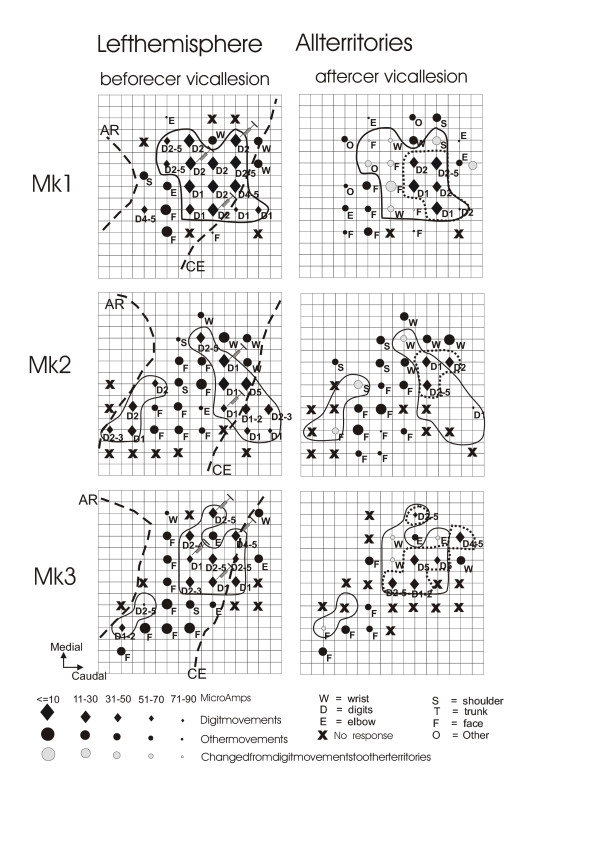
Intracortical stimulation mapping of the ipsilesional motor cortex. Somatotopic map in the motor cortex on the left (ipsilesional) hemisphere in the region of the hand area, before (left column) and after (right column) the cervical lesion for Mk1, Mk2 and Mk3 (from top to bottom). The data are presented on a surface view of the cerebral cortex, the portion accessible via the chronic recording chamber. The pre-lesion maps were established by daily ICMS sessions conducted during the 3 months preceding the lesion. The post-lesion maps were derived from daily ICMS sessions starting 2, 4.5 and 5 months after the lesion in Mk1, Mk2 and Mk3, respectively and lasting about 2 months each. Each symbol represents the location on the cortical surface of the penetration with an electrode for ICMS. The ICMS data given for each symbol is representative for the site of stimulation where the effect was observed at the lowest current intensity along the considered electrode track. The letter next to each symbol indicates the body territory activated at threshold for each track (see letter codes in the bottom right). The size of the symbols indicates the current intensity at threshold (in μA; see bottom left). Hand area(s), outlined by a solid line, was defined as a cortical region pre-lesion where ICMS at lowest threshold elicits movements of the fingers (electrode tracks represented by diamonds). Symbol X means that ICMS did not elicit any visible movement of muscles. The pointed lines outline the hand area, as defined post-lesion. Symbols in grey are for sites belonging to the hand area before lesion, which became part of other territories post-lesion. The grid in the background indicates steps of 1 mm. Syringes point to sites where muscimol was infused in order to inactivate M1 (see text). In order to make sure that the entire "post-lesion" hand representation was reversibly inactivated, the sites of infusion of muscimol were selected based on the "pre-lesion" map, exhibiting a larger hand representation than post-lesion. On the pre-lesion maps (left column), the approximate positions of the central (CE) and arcuate (AR) sulci are indicated by dashed lines.